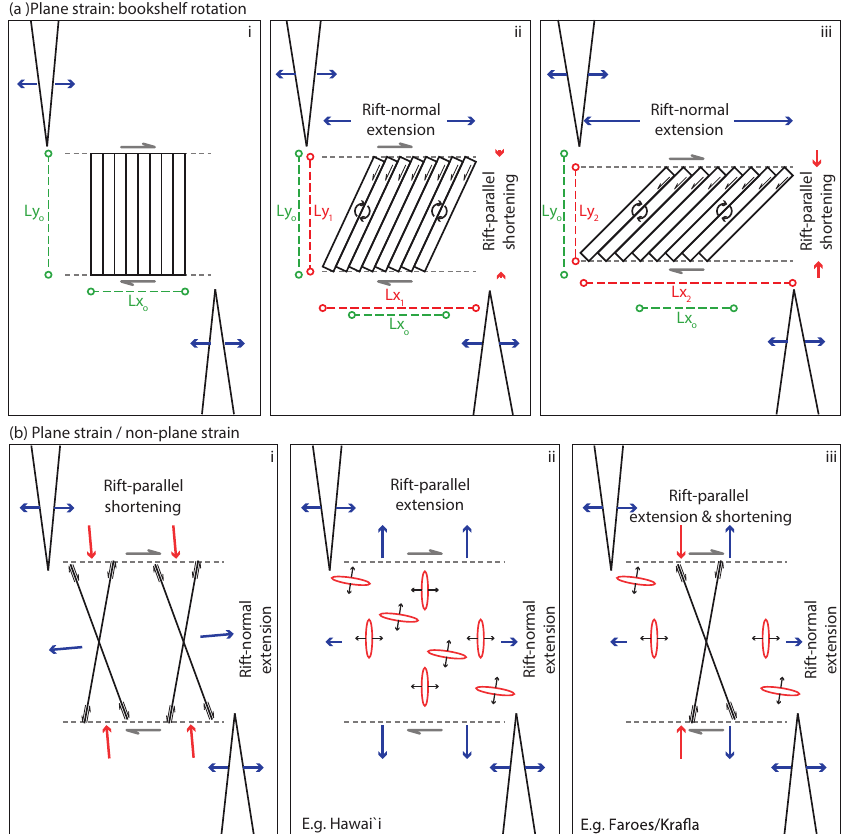
Figure 10. Horizontal plane 2-D conceptual models for inter-fault and inter-rift relay rotation. (a) Bookshelf rotation model showing (i– iii) progressive rotation leading to rift-normal extension and rift-parallel shortening. (b) Schematic models for structures observed in the study areas presented here: (i) conjugate extensional shear faults, (ii) extension fractures, and (iii) a combination of extension fractures and conjugate extensional shear faults. If faults develop throw, as in the Krafla example, the system becomes non-plane strain. Models are not to